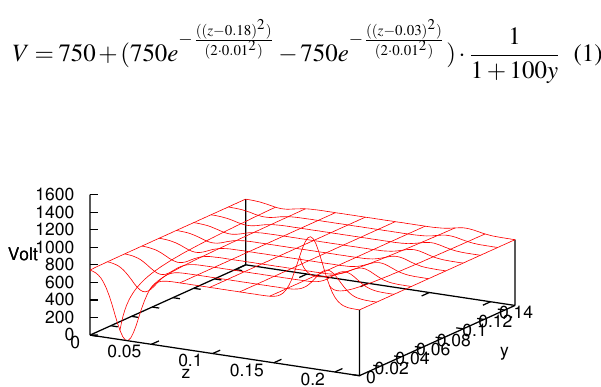
Fig. 24: Initial voltage values for simulation. The z-axis is going along the thigh, while the y-axis is going from front to back through the